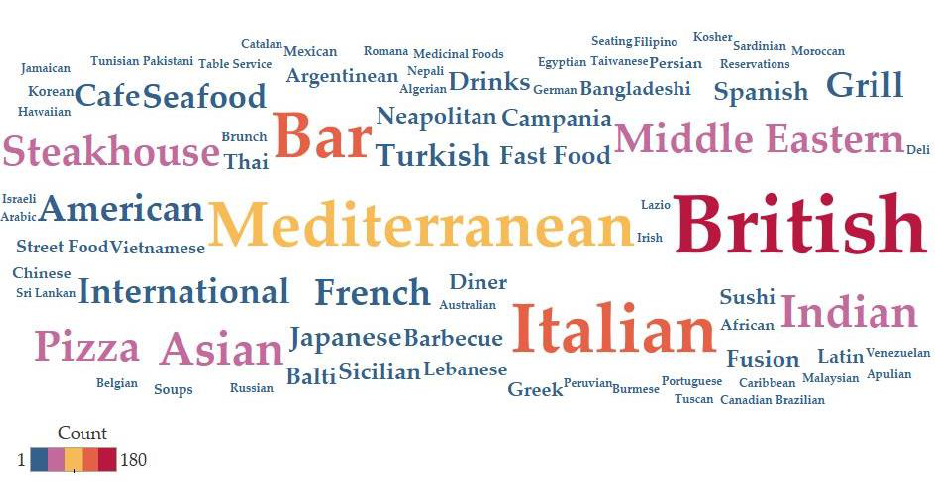
Figure 6. Word cloud of the cuisines.